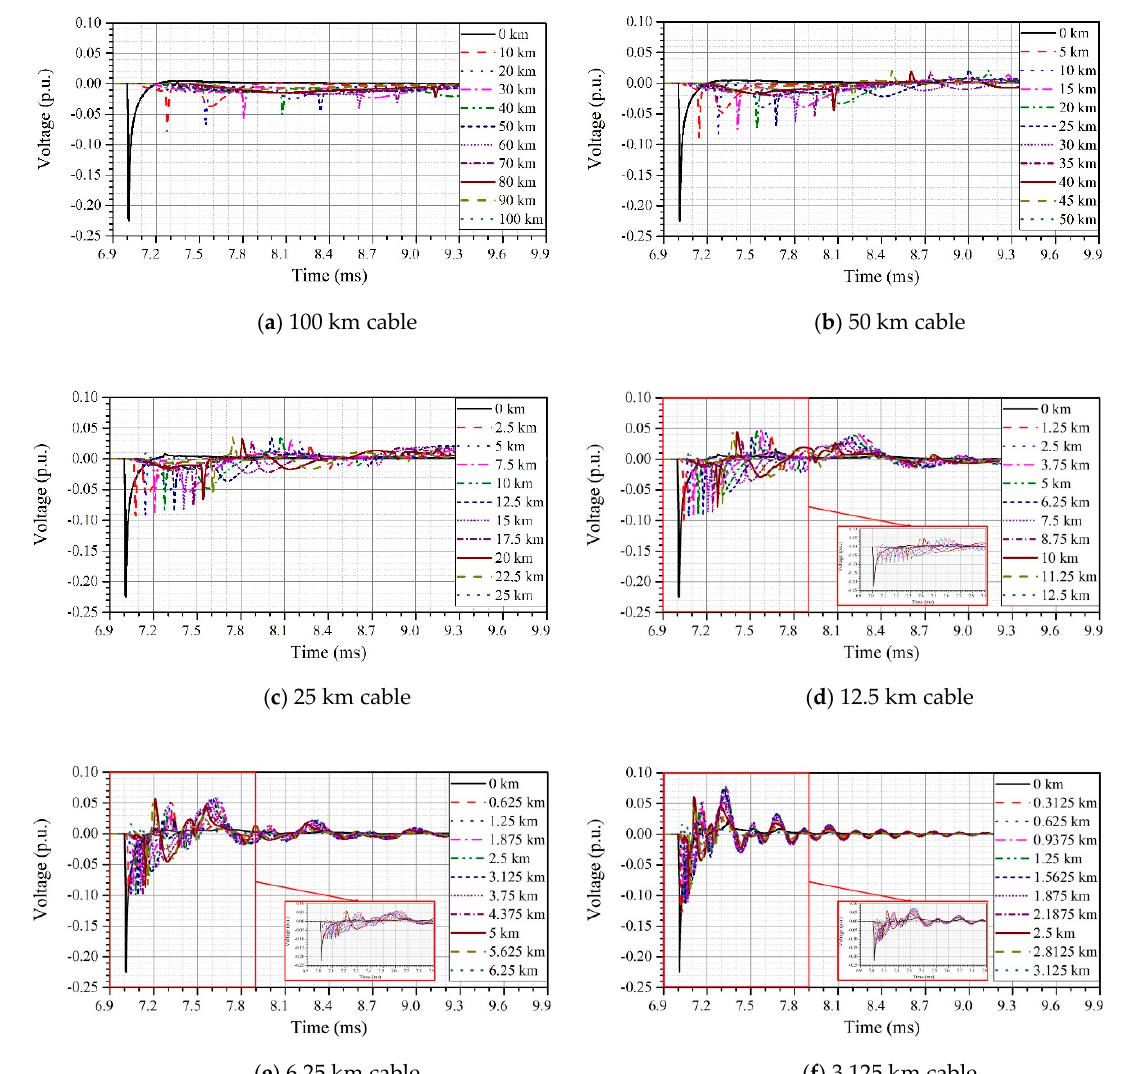
Figure 12. Sheath-ground overvoltage at the sending end terminal of the cables considering different cable lengths.